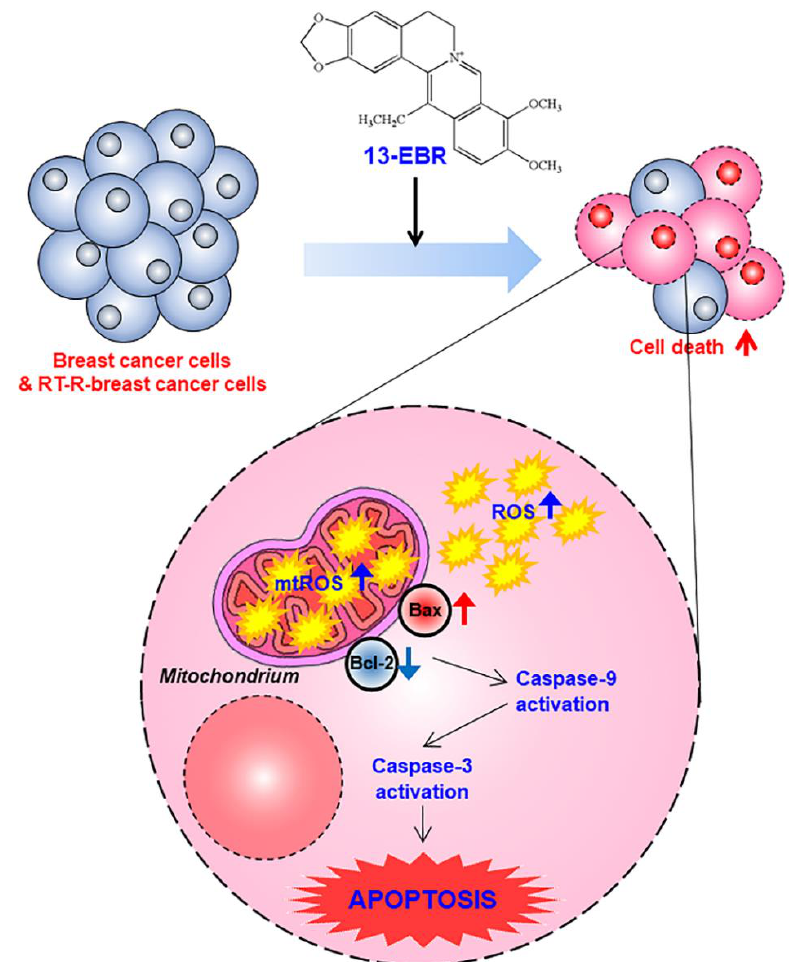
Figure 5. A proposed mechanism via which 13-EBR exhibits anticancer effects in triple-negative